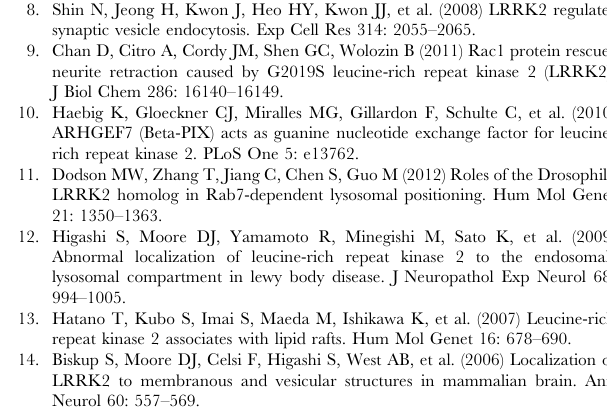
Figure S3 Co-localization analysis of DsRed-Monomer- Rab32 wt and DsRed-Monomer-Rab32 Q85L with GFP- Rab5A and GFP-Rab32 wt and GFP-Rab32 Q85L with endogenous Rab9. (A) For Rab5 co-localization analysis NIH3T3 cells were co-transfected with plasmids encoding for DsRed-Monomer-Rab32 wt or DsRed-Monomer-Rab32 Q85L and the early endosomal marker protein GFP-Rab5A. Cells were fixed in 4% PFA and subjected to microscopic analyzes. Scale bar = 10 m m. (B) For Rab9 co-localization analysis NIH3T3 cells were transfected with the indicated GFP-Rab32 wt or GFP-Rab32 Q85L expression plasmids. 24 hours after transfection cells were fixed and subjected to secondary immunofluorescence staining of Rab9. Scale bar = 10 m m. Figure S4 Co-localization analysis of LRRK2-GFP with Rab7 and Rab11. For co-localization analysis NIH3T3 cells were transfected with plasmids encoding for LRRK2-GFP and immunostained for Rab7 or Rab11 localization, respectively. Cells were fixed in 4% PFA and subjected to microscopic analyzes. Scale bar = 10 m m. Figure S5 Golgi and endosomal co-localization of GFP- Rab32 wt. IHKE-1 cells were transiently transfected with pEGFP-Rab32 wt. After 24 hours cells were fixed and immuno- stained for the indicated proteins. Scale bar= 10 m m. Figure S6 Analysis of GFP-Rab32 wt and GFP-Rab32 Q85L co-localization with Rab7 and LAMP2 in IHKE-1 cells. (A) IHKE GFP-Rab32 wt and IHKE GFP-Rab32 Q85L cells were grown on glass cover slips, fixed and stained for Rab7 by secondary immunofluorescence. Scale bar =10 m m. (B) IHKE GFP-Rab32 wt and IHKE GFP-Rab32 Q85L cells were grown on glass cover slips, fixed and stained for LAMP2 by secondary immunofluorescence. Scale bar = 10 m m. Figure S7 LRRK2 expression in untransfected (IHKE-1) and IHKE GFP-Rab32 wt cells upon Bafilomycin A treatment. Western blots of endogenous LRRK2 and LC3B of IHKE-1 and stably GFP-Rab32 wt expressing IHKE-1 cells. Cells were grown for 24 hours. After incubation with 100